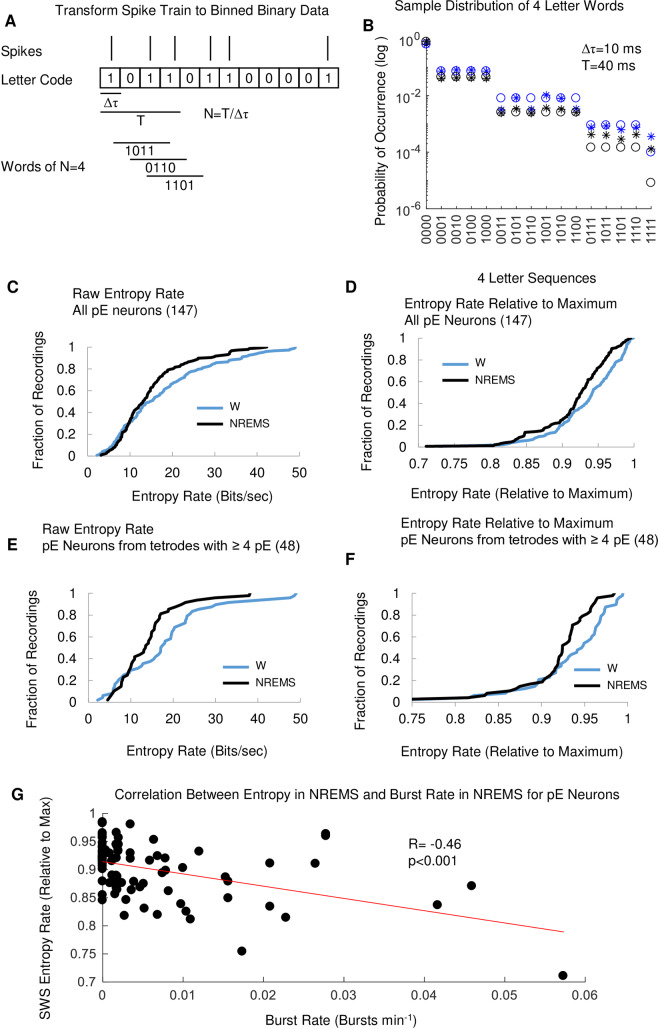
Single-neuron spike trains exhibit lower individual entropy rates in NREMS compared to W.(A) Schematic of the transformation of spike trains into a binned binary letter sequences and formation of N = four letter words. Bin duration is Δτ, word duration is T. (B) Examples of four-letter word distribution (0000 to 1111) in W (blue) and NREMS (black) from one M1 neuron recorded in W and NREMS. Stars show the actual occurrence probabilities and circles the calculated probabilities from the firing frequency (see Methods for definition of occurrence and calculated probability). (C) Individual entropy rate [(entropy for all words of duration T)/T] for pE neurons in W and NREMS for bin size 10 ms and word length 4. Entropy rate was significantly lower in NREMS (14.9±0.7 Bits/sec) compared to W (17.8±1.0 Bits/sec), (N = 147, p<0.001, Wilcoxon related samples signed rank test). (D) Entropy rate relative to maximal entropy rate in W and NREMS (see Methods). Relative NREMS entropy rate (0.92±0.004) was also significantly lower compared to W (0.94±0.004) (N = 147, p<0.001, Wilcoxon related samples signed rank test). (E & F) Same data as in C&D, but for pE neurons from tetrodes with four simultaneously recorded pE neurons. Both the entropy rate and the rate relative to maximum were lower in NREMS (14.2±1.1 Bits/sec and 0.92±0.006) compared to W (18.3±1.7 Bits/sec and 0.93±0.007) (N = 48, p<0.001 and p = 0.012, Wilcoxon related samples signed rank test). (G) Scatter plot of relative entropy rate in NREMS versus burst rate (black dots) for pE neurons. Red line shows linear fit to the data. Increased burst rates negatively correlated with relative entropy in NREMS. Pearson's correlation coefficients (R) and p values are indicated on the graphs (N = 105).